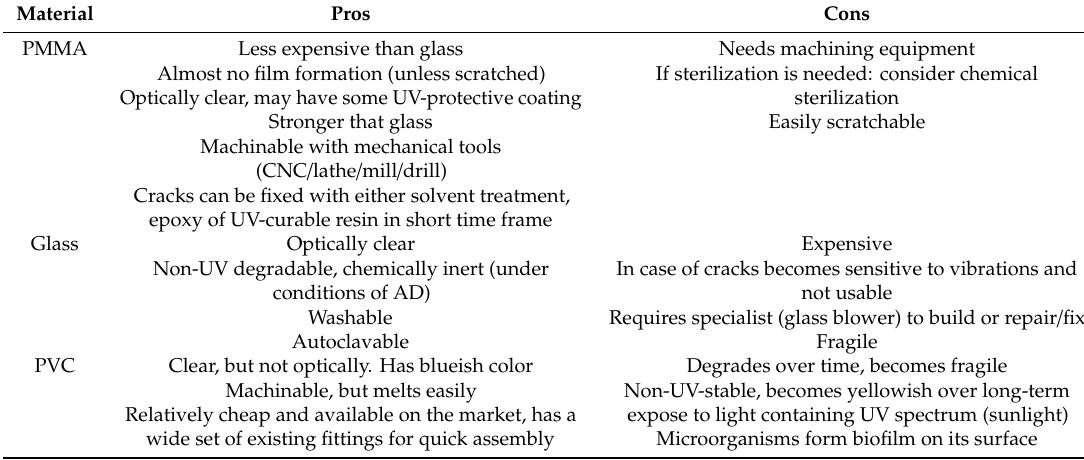
Table 5. Comparison of materials used for UASB reactors in various